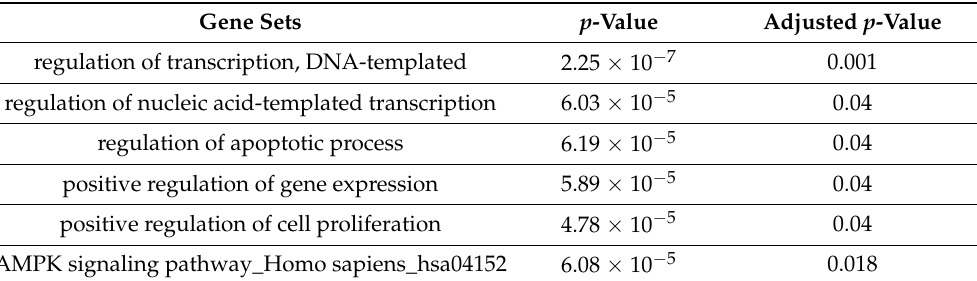
Table 4. The gene set enrichment analysis using